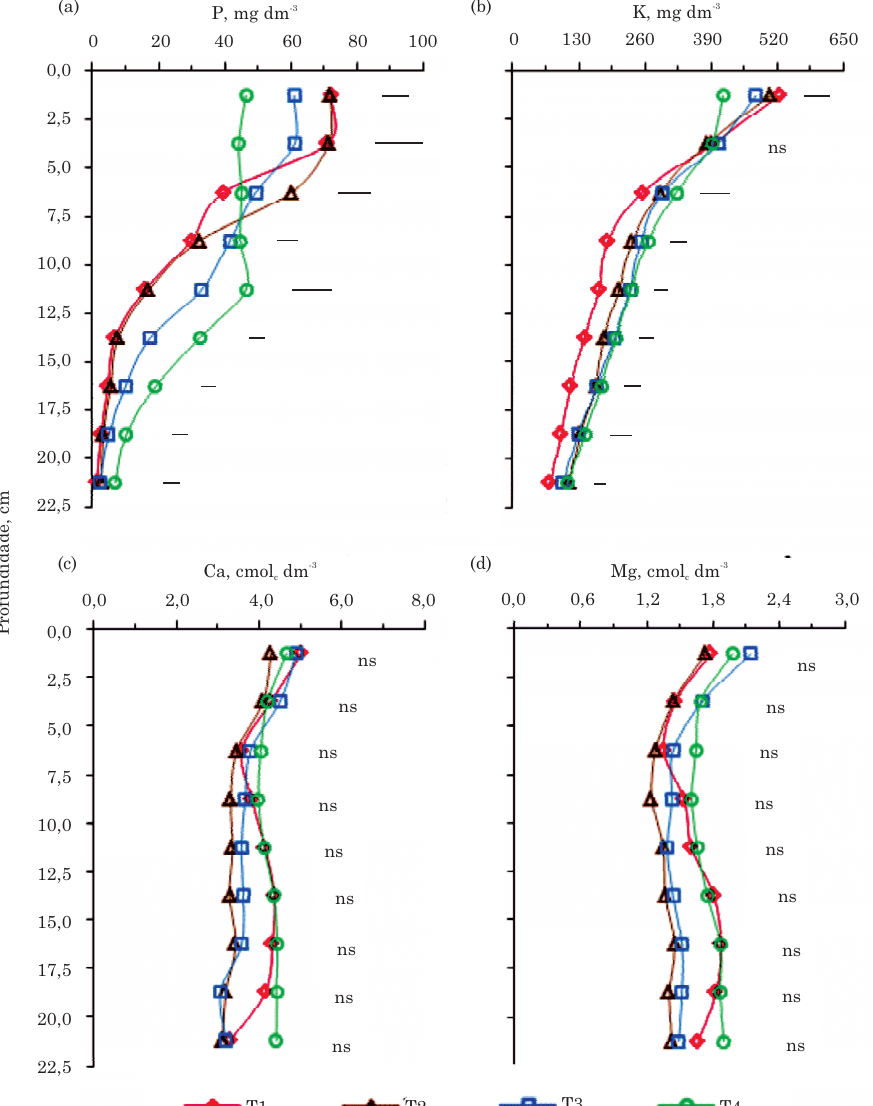
Figura 3. Concentrações de P (a) e K (b) disponíveis, Ca (c) e Mg (d) trocáveis, oito meses após a semeadura de milho ( Zea mays L.), com semeadora equipada com haste sulcadora ajustada para operar a diferentes profundidades, em Latossolo Vermelho sob plantio direto, na linha de semeadura. T 1 : ação da haste sulcadora a 5 cm; T 2 : ação da haste sulcadora a 10 cm; T 3 : ação da haste sulcadora a 1 5 cm; e T 4 : ação da haste sulcadora a 17 cm; Barras horizontais representam a diferença mínima significativa pelo teste Tukey a 5 %, entre os